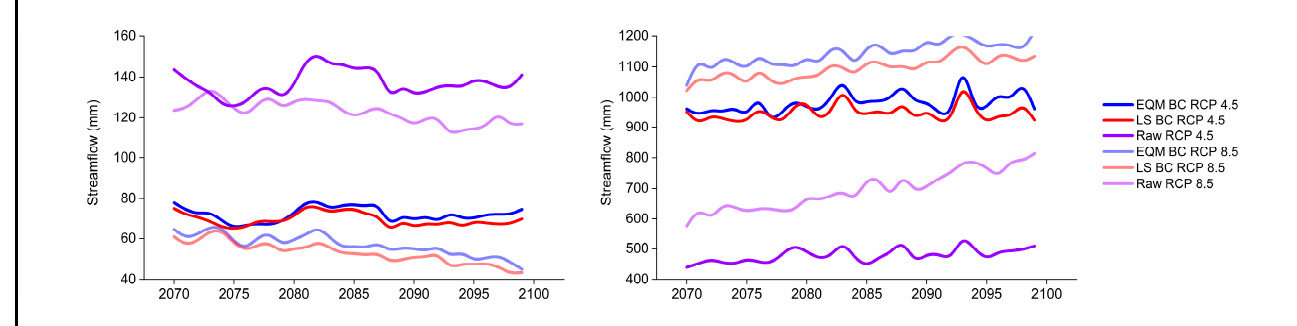
Figure 13. As Figure 8, but for the period 2070–2099.